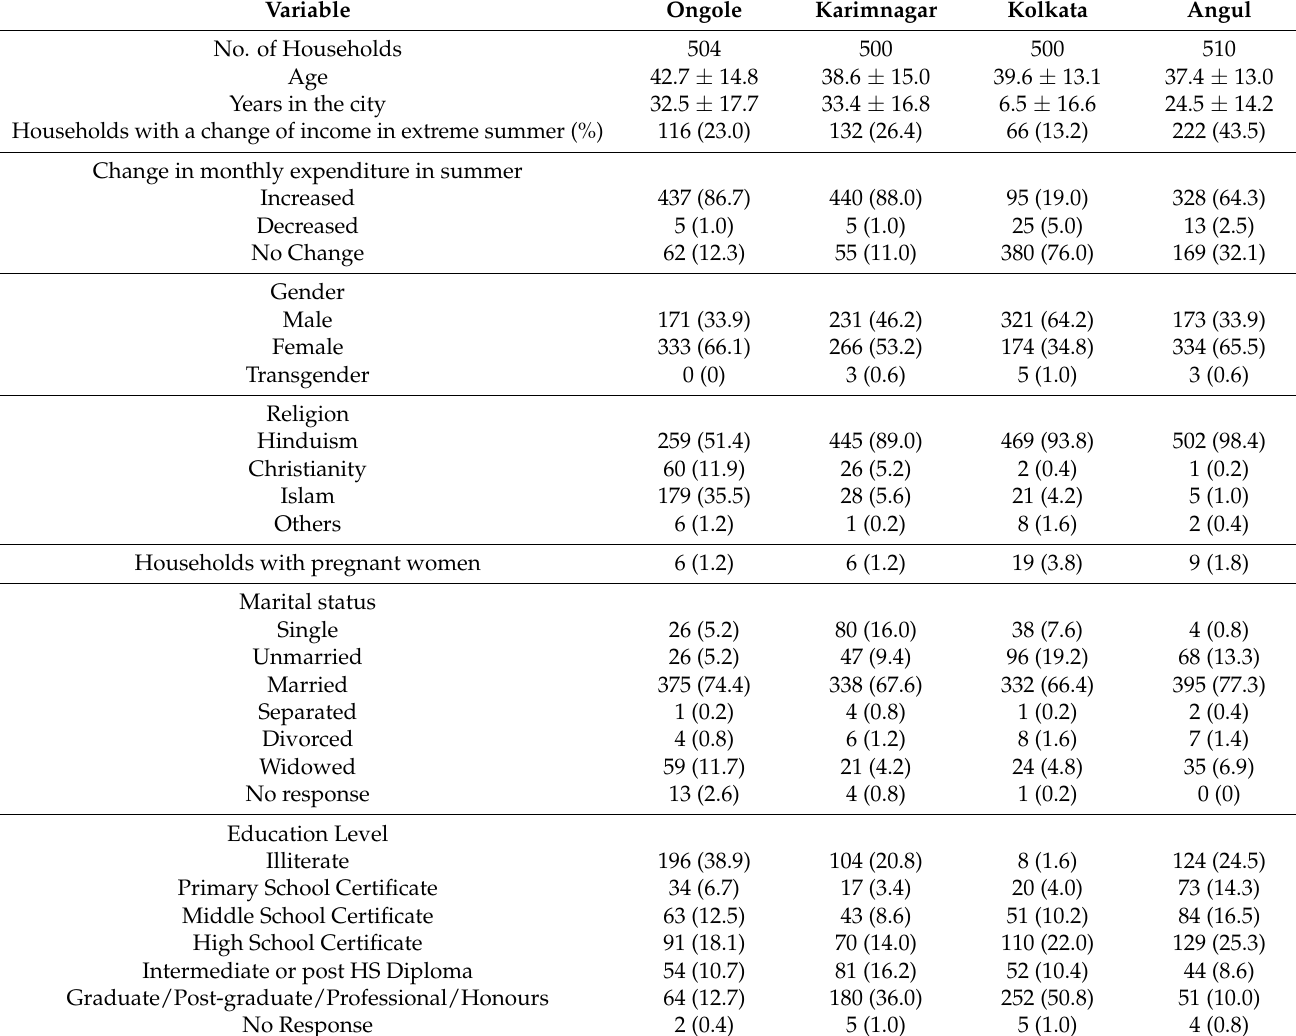
Table 2. Socio-demographic characteristics for the population of four Indian